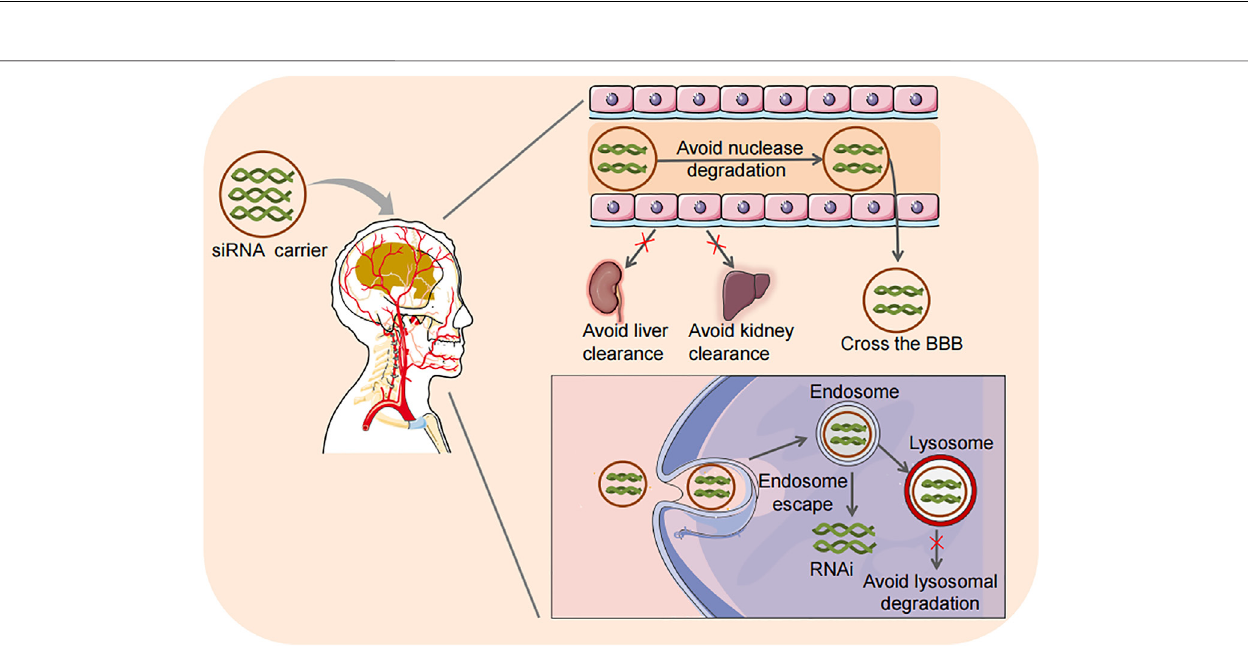
FIGURE 3 | Advantages of siRNA delivery strategies. Loading siRNA into carriers has the advantages of preventing nuclease degradation, reducing the clearance by the kidney and liver, effectively crossing the BBB, facilitating endosome-lysosome escape, and avoiding lysosome degradation in cells. RNAi, RNA interference.